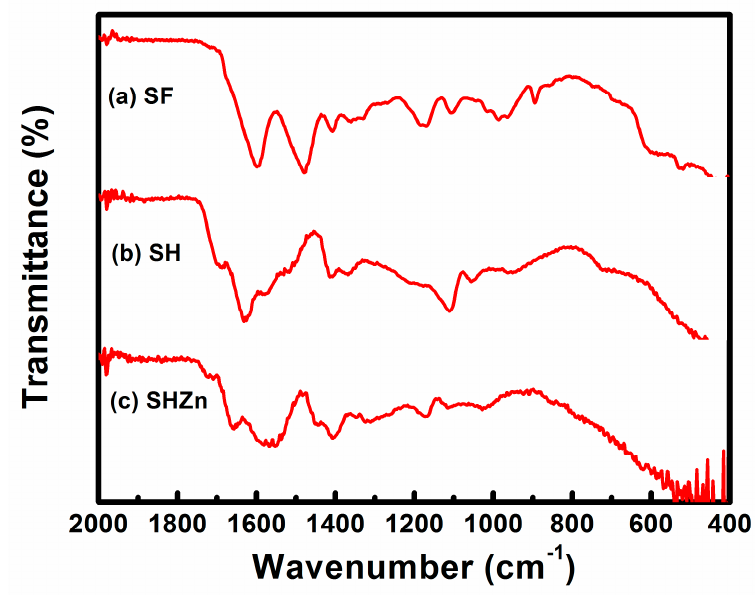
Figure 1. FTIR spectra of ( a ) SF, ( b ) SH, ( c ) SH-ZnO.